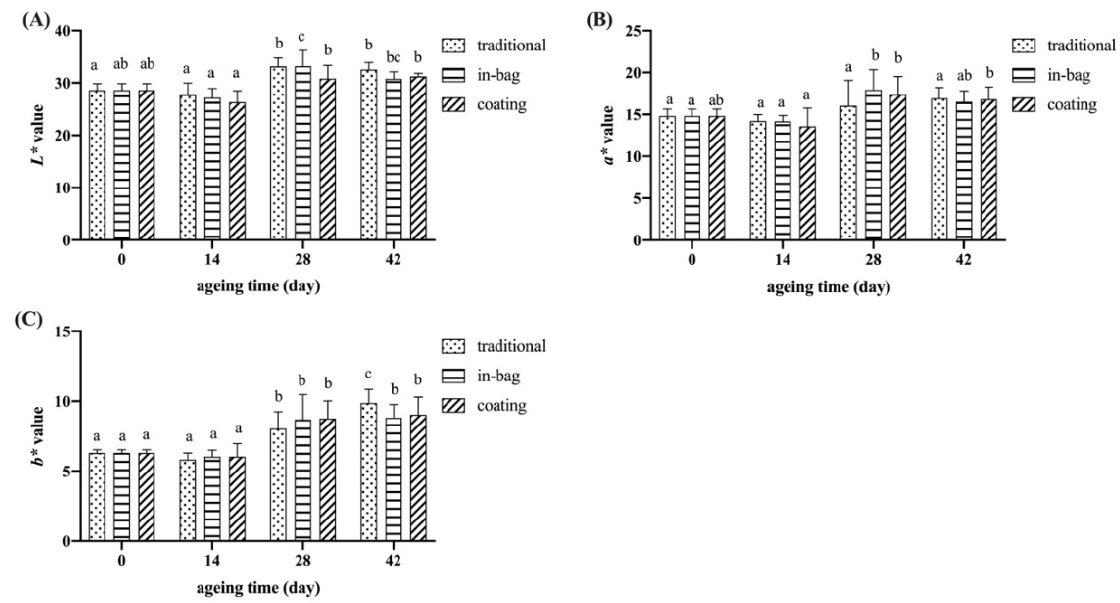
Figure 1. Effects of different treatments on L* ( A ), a* ( B ), and b* ( C ) values of dry-aged beef. a–c Means having same lowercase letters indicate no significant differences between ageing times for the same group, p > 0.05.